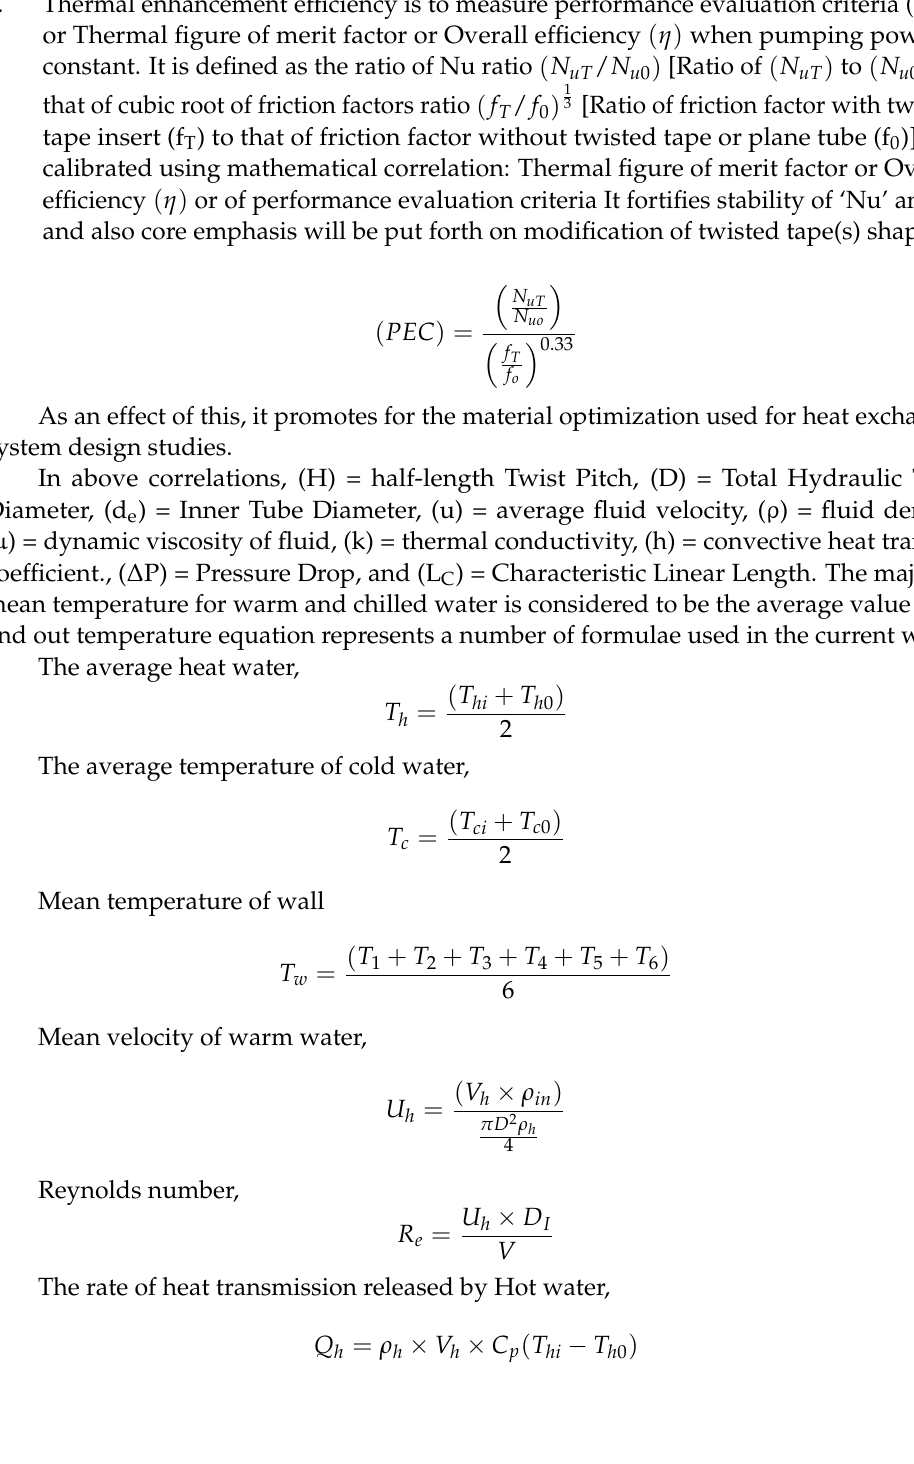
Friction factor is proportionality between the product of tube’s total pressure decrease and corresponding Inner Tube Diameter equals the square of the average fluid velocity in the tube multiplied by density, characteristic linear dimension, and inner tube diameter. It is shown in use by ‘ f ’.